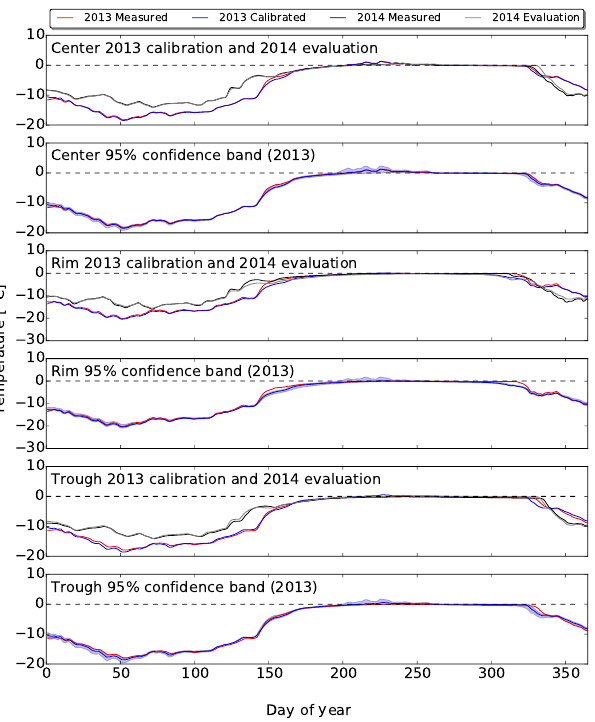
Figure 3. Time-series of temperature at 40cm depths plotted as a function of the day of the year for the polygonal center, rim, and trough profiles. Alternating plots include measured values from the BEO for 2013 (red line) and 2014 (grey line) and simulated tem- peratures from the 2013 calibration (blue line) and 2014 evaluation (black line). Every other plot contains the 2013 95% confidence band for the NSMC ensemble as a shaded light blue